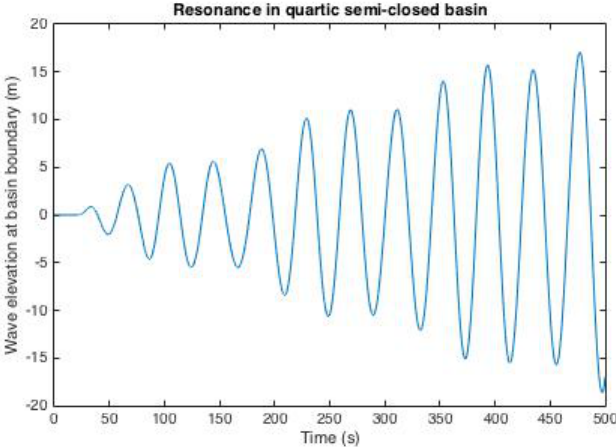
Figure 7. Simulation result for quartic semi-closed basin.